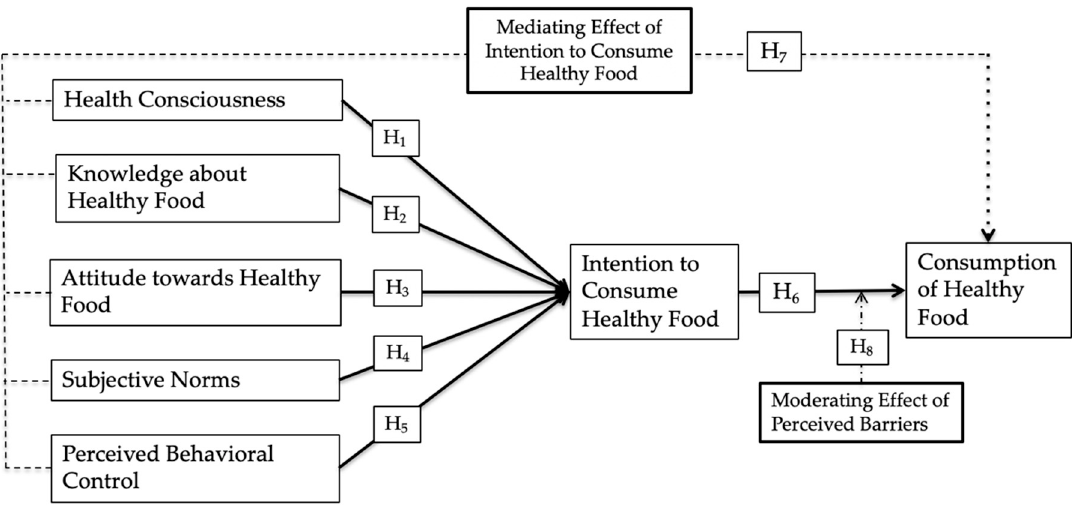
Figure 1. Research framework.